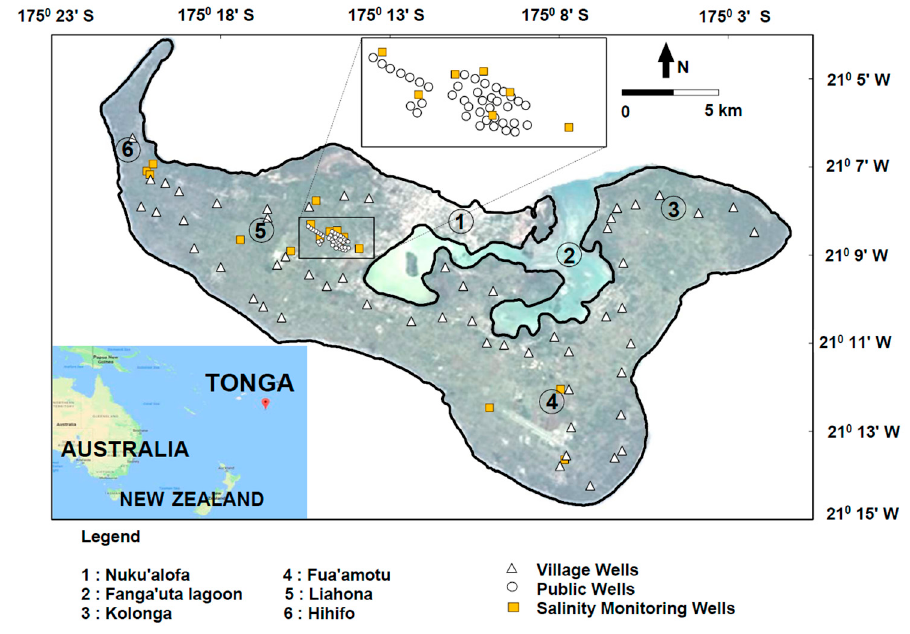
Figure 1. Island of Tongatapu.